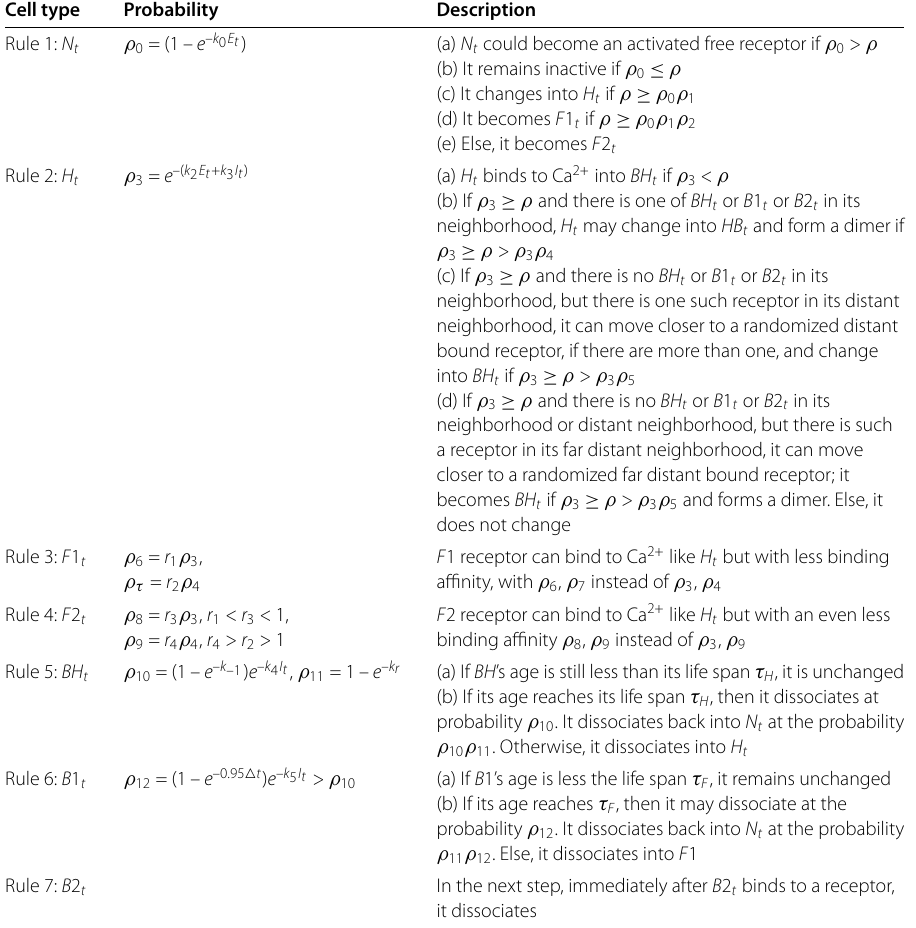
Table 2 Updating rules for all states in the lattice Cell